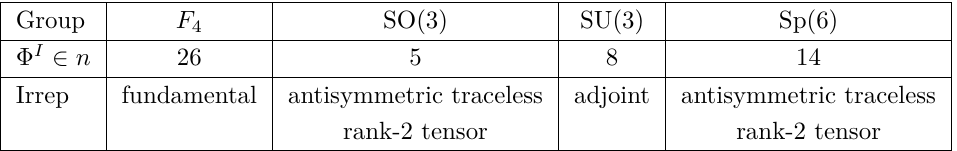
Table 3 . F 4 family of invariant groups and the dimension of the corresponding of representation. The row “Irrep” shows the name of the irreps if a commonly used exist.